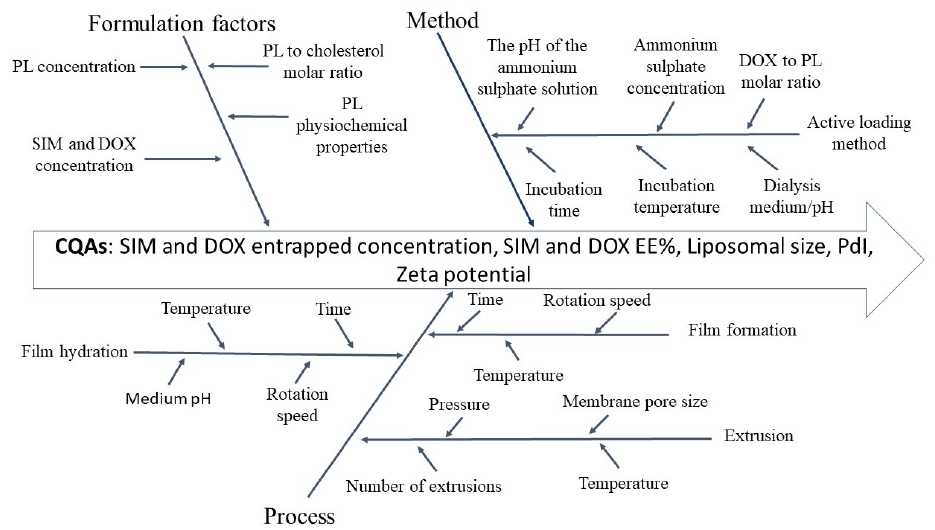
Figure 1. Ishikawa diagram summarizing the material attributes and process parameters with a potential impact on SIM-DOX-LCL CQAs.